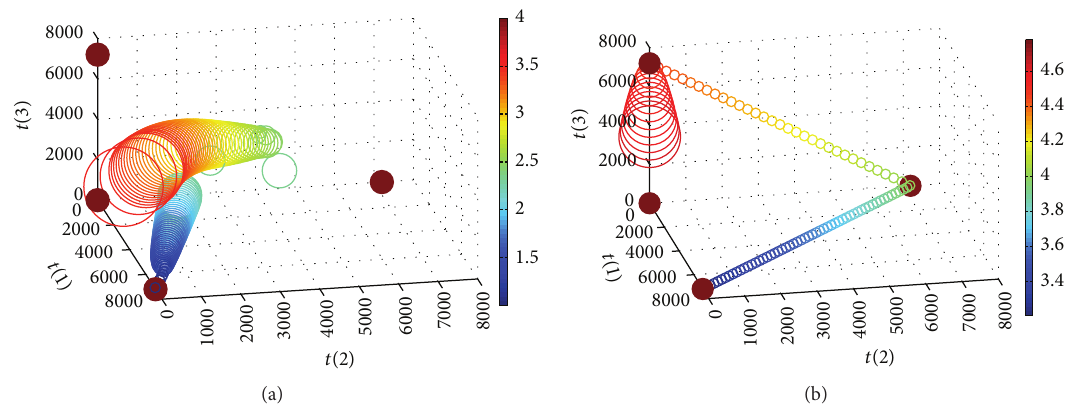
Figure 6: Situations 1 and 2 in the objective space.